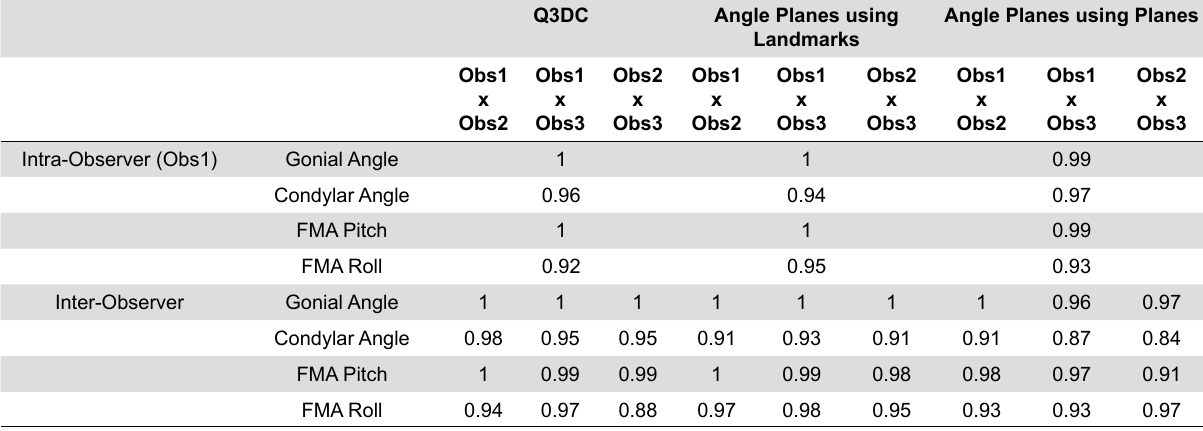
Table 1- Intra- and inter-observer correlation assessment